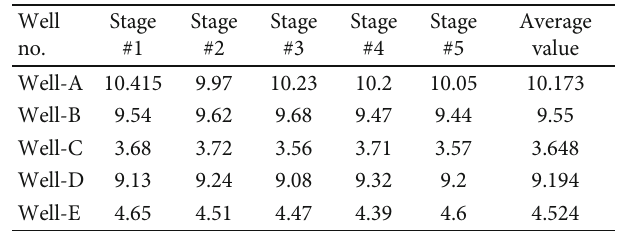
Figure 2: Comparison of treated fl ow-back water and fresh water in hydraulic Table 2: Annual and daily saving water in hydraulic fracturing Table 3: Treated fl ow-back water at di ff erent stages based on MM processes. m 3 for one day in chemical recovery techniques.